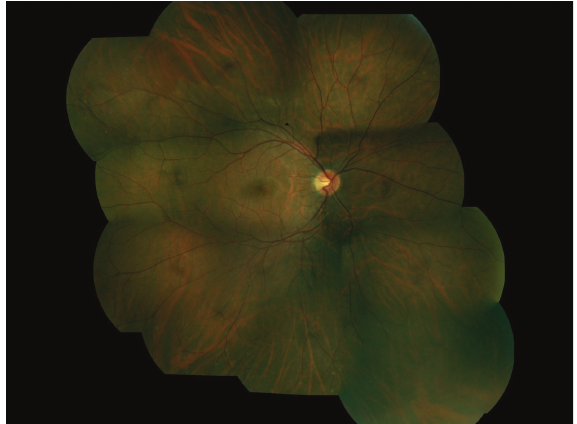
Figure 1: Color fundus photo montage OD. Exam was remarkable for mild vessel narrowing with areas of hypopigmentation most notable in the superotemporal periphery, although also noted in the inferior/inferonasal periphery. Peripapillary depigmentation (more evident temporally and less extensive than the ring of depigmentation noted OS) is present. Biomicroscopy revealed subtle reddish spots, not consistent with hemorrhage, within areas corresponding to the areas of the visual field where he described symptoms. These subtle red spots were most notable in the far inferonasal periphery and are di ffi cult to appreciate in the photos.